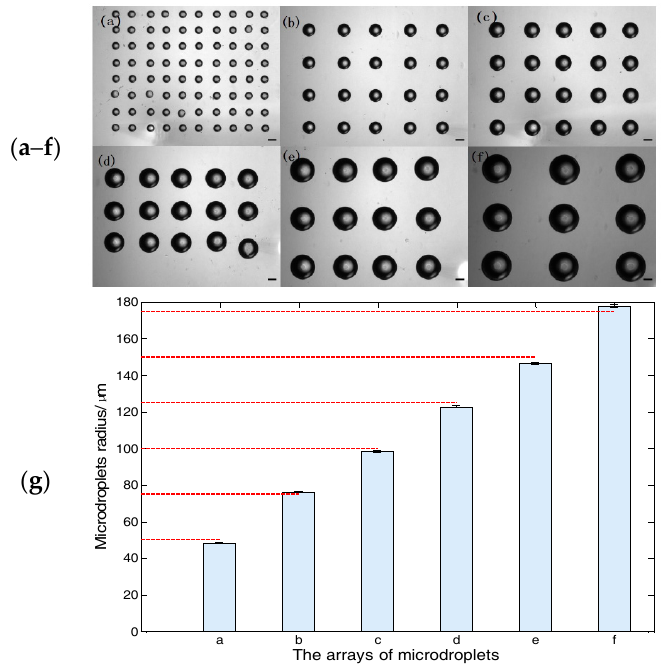
Figure 12. The experimental results and analysis. ( a – f ) The bright-field image of microdroplets, the scale bar is 100 μ m (see Supplementary Video S2). ( g ) the uniformity analysis of the microdroplets’ radii, the column denotes the radius mean and the dashed red lines are the desired radii. The error bar are the standard errors, which are 0.66%, 0.33%, 0.38%, 0.46%, 0.33%, and 0.43%, respectively.